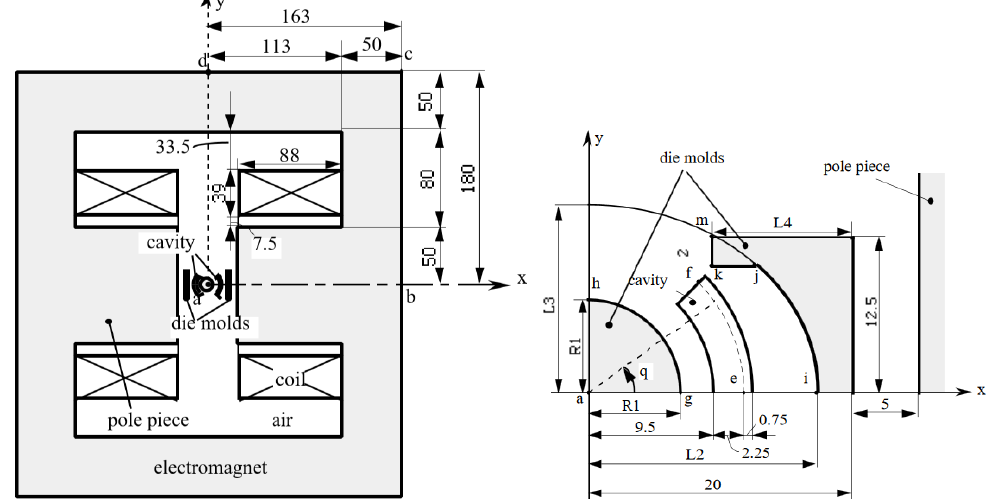
Figure 3. Model of die press with electromagnet, (left) whole view (right) enlarged view